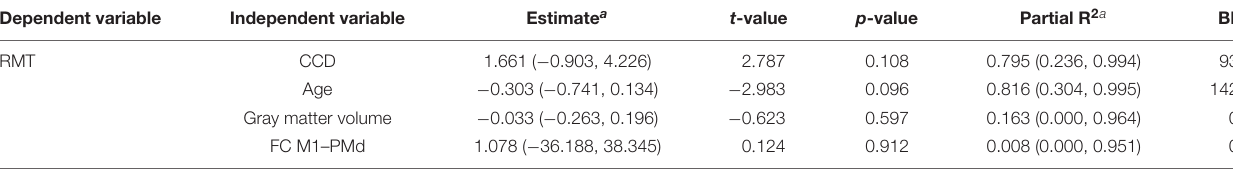
TABLE 5 | Multiple regression model for the subgroup and dominant hemisphere.